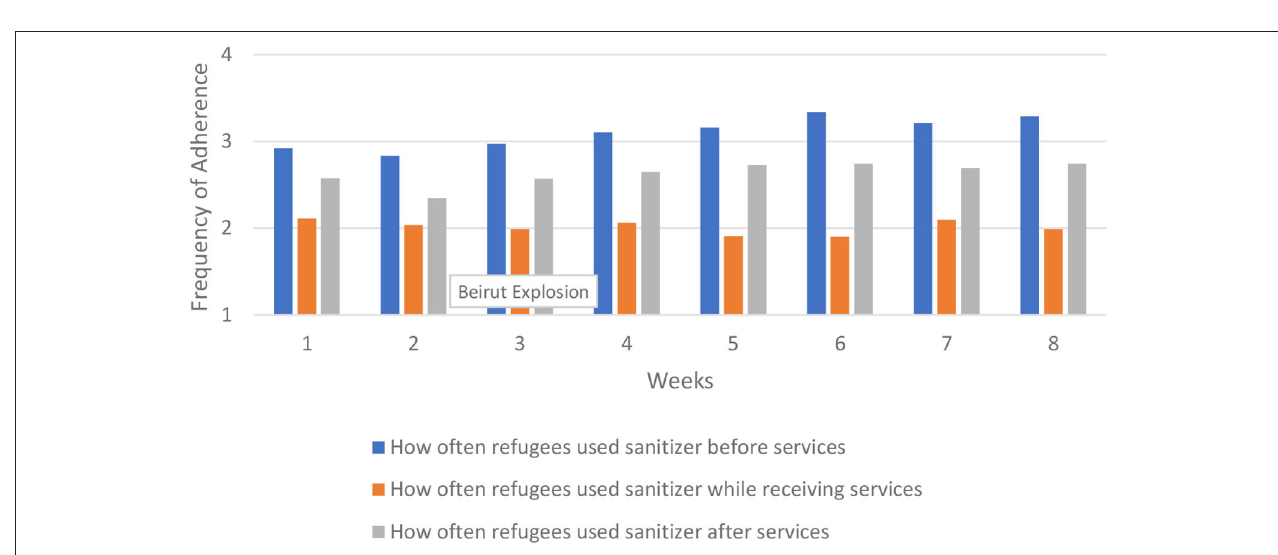
FIGURE 4 | Refugee sanitizer use across